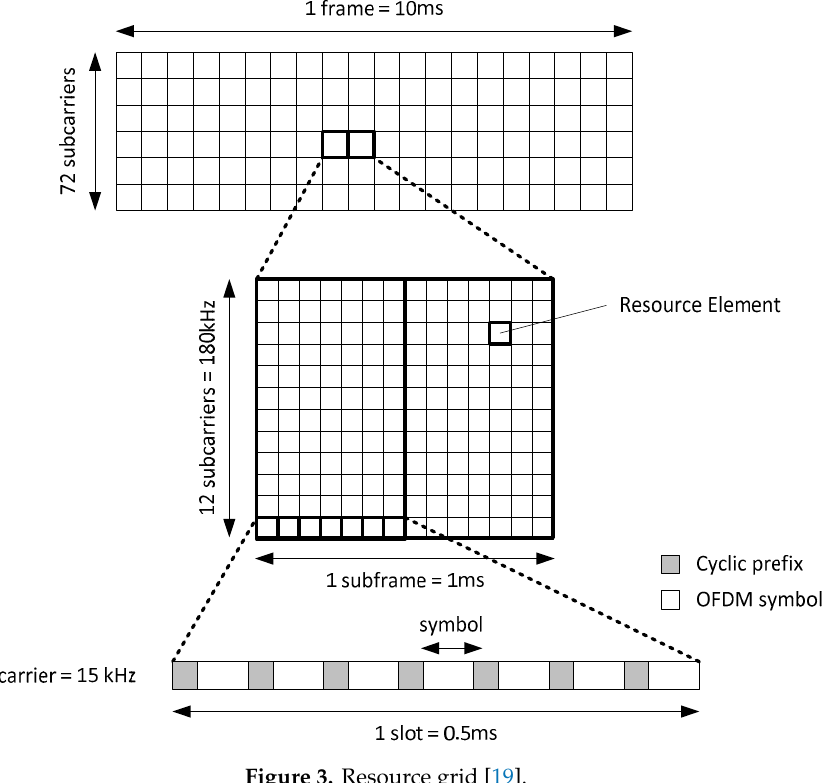
Figure 3. Resource grid [19].